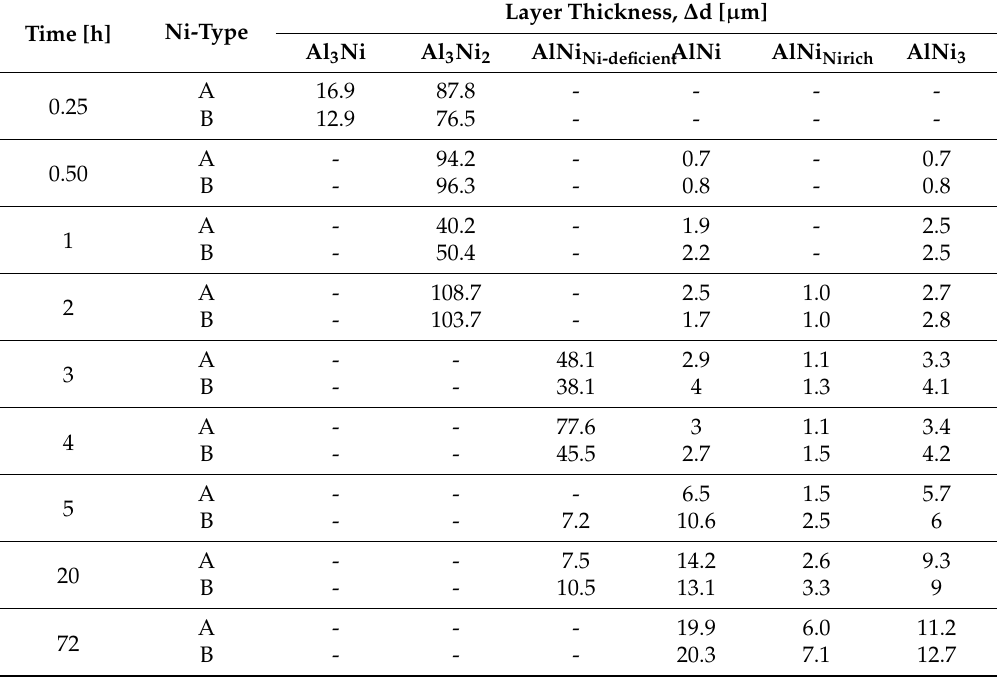
Table 5. The thickness of the particular layers of the intermetallic phases formed in Ni/Al/Ni interconnection in different time of reaction at 720 ◦